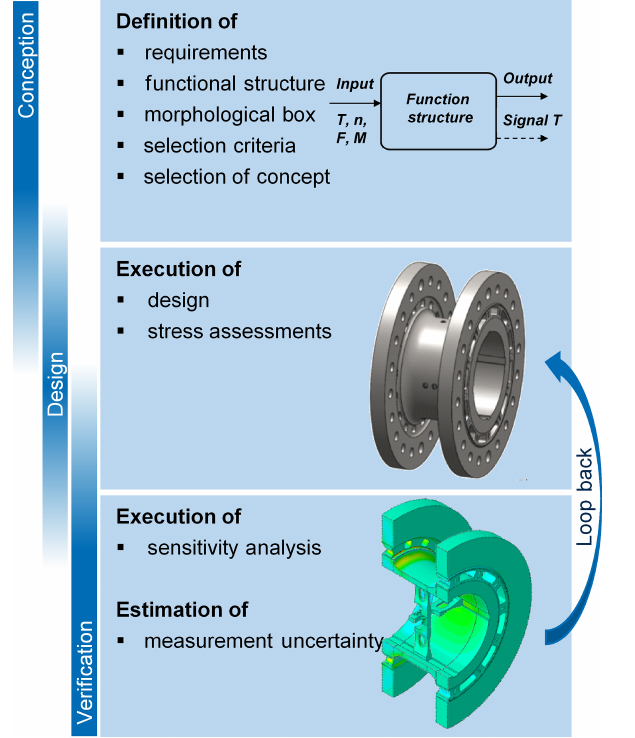
Figure 2. Approach of the design study of the